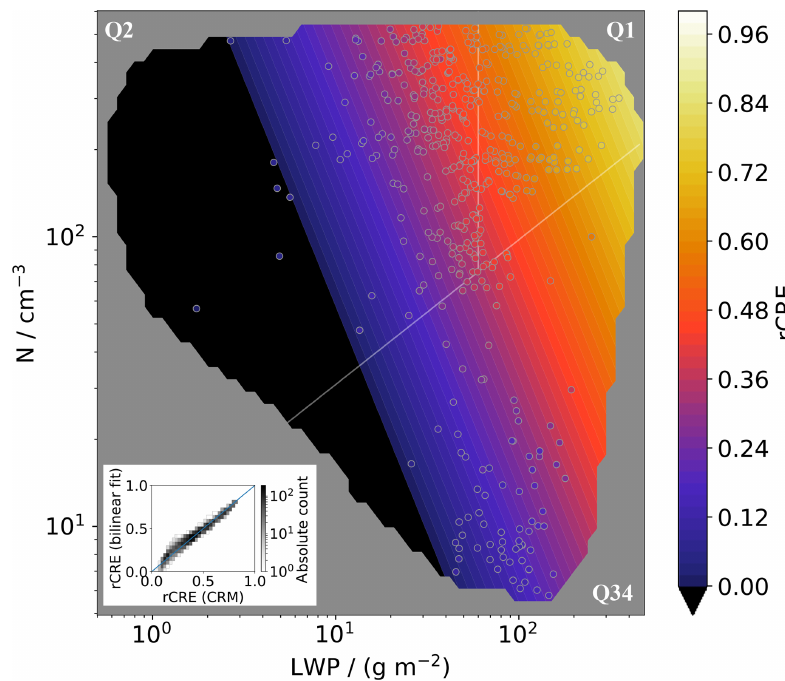
Figure 9. Same as Fig. 5 but using bilinear regression rCRE = a · log 10 ( LWP ) + b · log 10 (N) + c instead of emulation to obtain the surface. From the regression, we obtain a = 0 . 40, b = 0 . 26 and c = − 0 . 86 with a coefficient of determination of r 2 = 0 . 95 and RMSE = 0 .